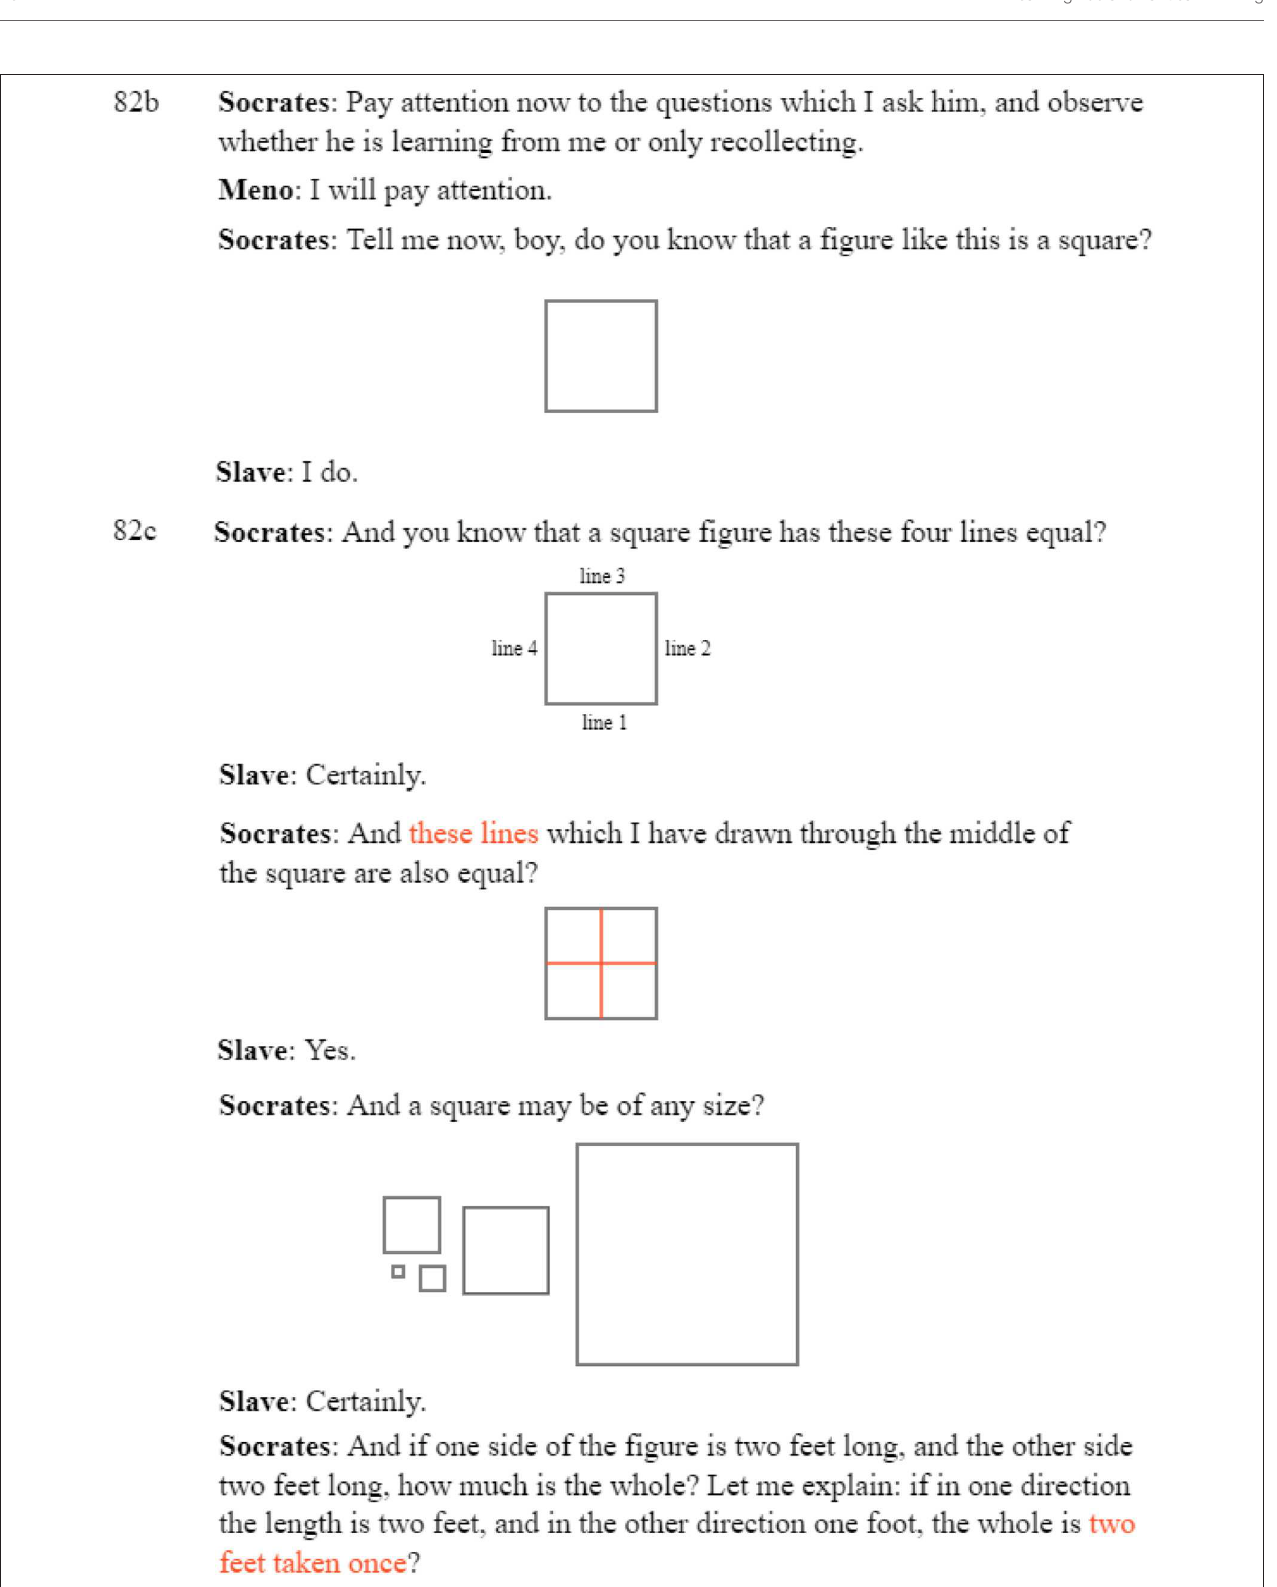
FIGURE 1 | An illustration of modern Socratic dialogues (Meno 82b − 85d: Socrates and the Slave, Source: Wikimedia.org).